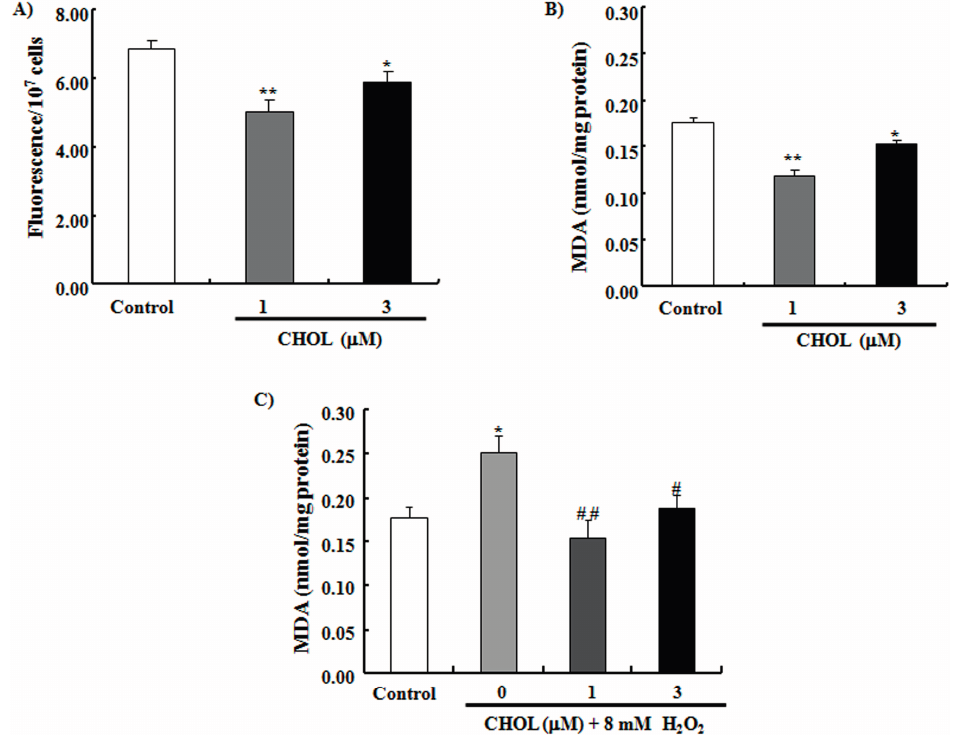
Figure 3. Effects of CHOL on reactive oxygen species (ROS) and malondialdehyde (MDA) production in yeast. ( A ) Effect of CHOL on ROS production. Fluorescence/(10 7 cells) in the control group was 6.83 ± 0.28; CHOL at 1 μ M, 5.03 ± 0.35; CHOL at 3 μ M, 5.91 ± 0.30; ( B ) Effect of CHOL on endogenous MDA production of yeast. MDA production in the control group was 0.18 ± 0.005 nmol/mg protein, CHOL at 1 μ M, 0.12 ± 0.006; CHOL at 3 μ M, 0.15 ± 0.003; ( C ) Effect of CHOL on MDA production of yeast under oxidative stress condition. MDA production in the control group was 0.18 ± 0.01 nmol/mg protein; Control group treated with 8 mM H 2 O 2 , 0.25 ± 0.02; CHOL at 1 μ M, 0.16 ± 0.02; CHOL at 3 μ M, 0.19 ± 0.02. Each experiment was conducted at least three times. Vertical bars represent the mean SEM of three assays. * p < 0.05 and ** p < 0.01 indicate statistically significant difference from the corresponding control. # p < 0.05 and ## p < 0.01 indicate statistically significant difference from the control treated with 8 mM H 2 O 2